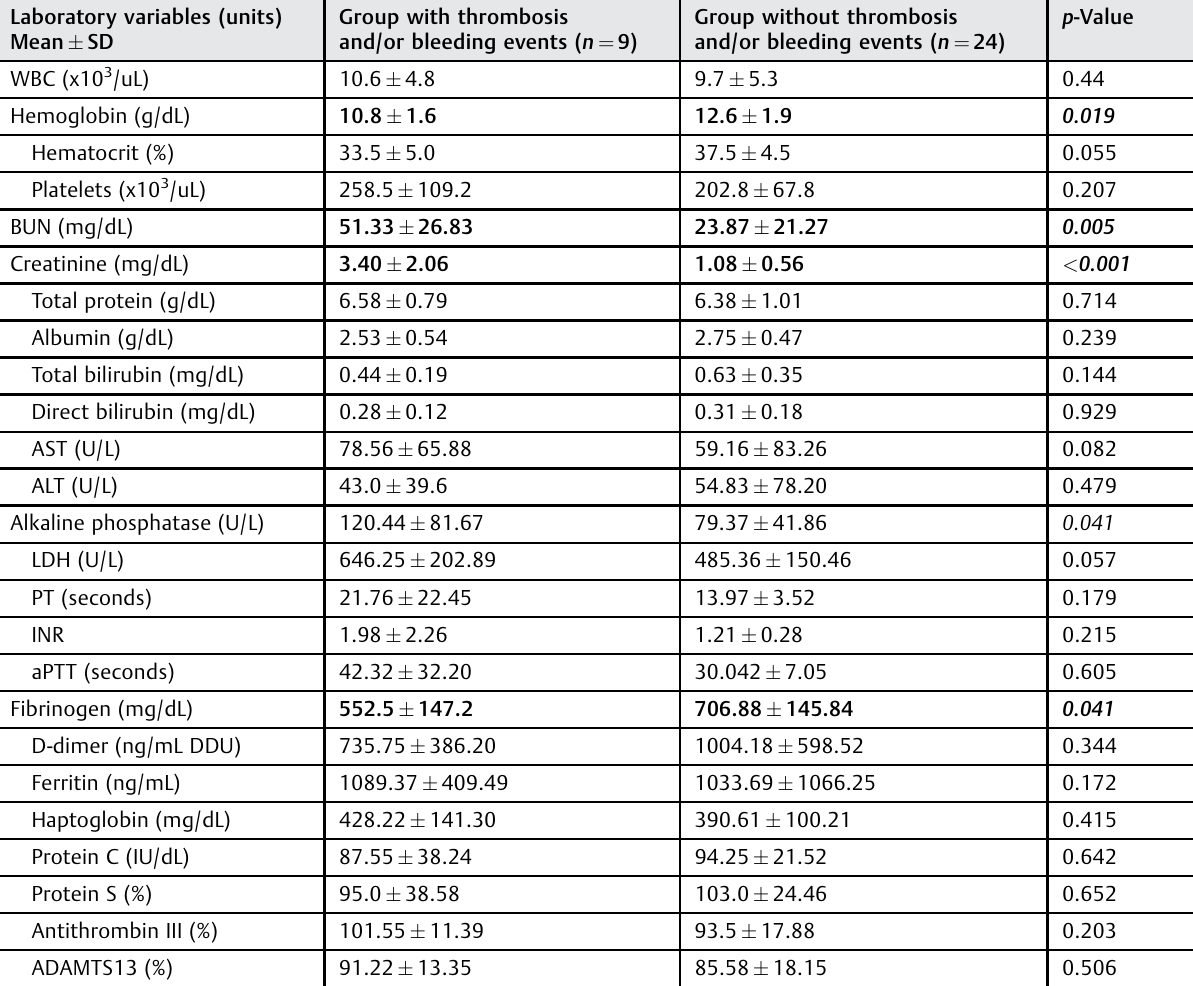
Table 2 Laboratory variables of groups with and without combined thrombosis and bleeding events Laboratory variables (units) Group with thrombosis Mean (cid:3) SD and/or bleeding events ( n ¼